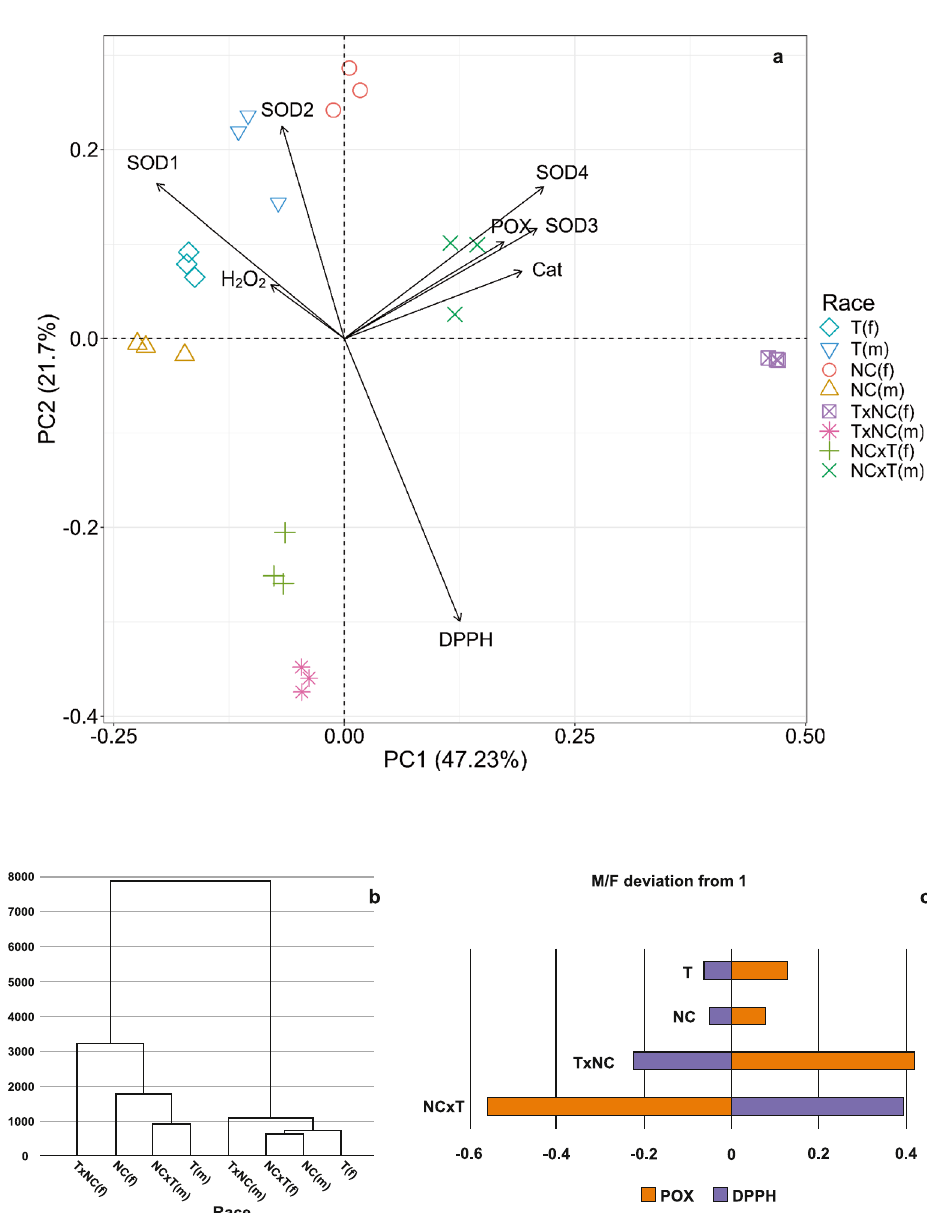
Figure 4. ( a ) Principal component analysis (PCA) biplot showing the relationship between the plant genotype and the activity of CAT, SOD, POX, free radical scavenging activity (DPPH) and the amount of H 2 O 2 ; ( b ) dendrogram of R. hastatulus genotypes based on Ward’s hierarchical clustering; ( c ) deviation from M/F equilibrium in activity of POX and LMW antioxidants